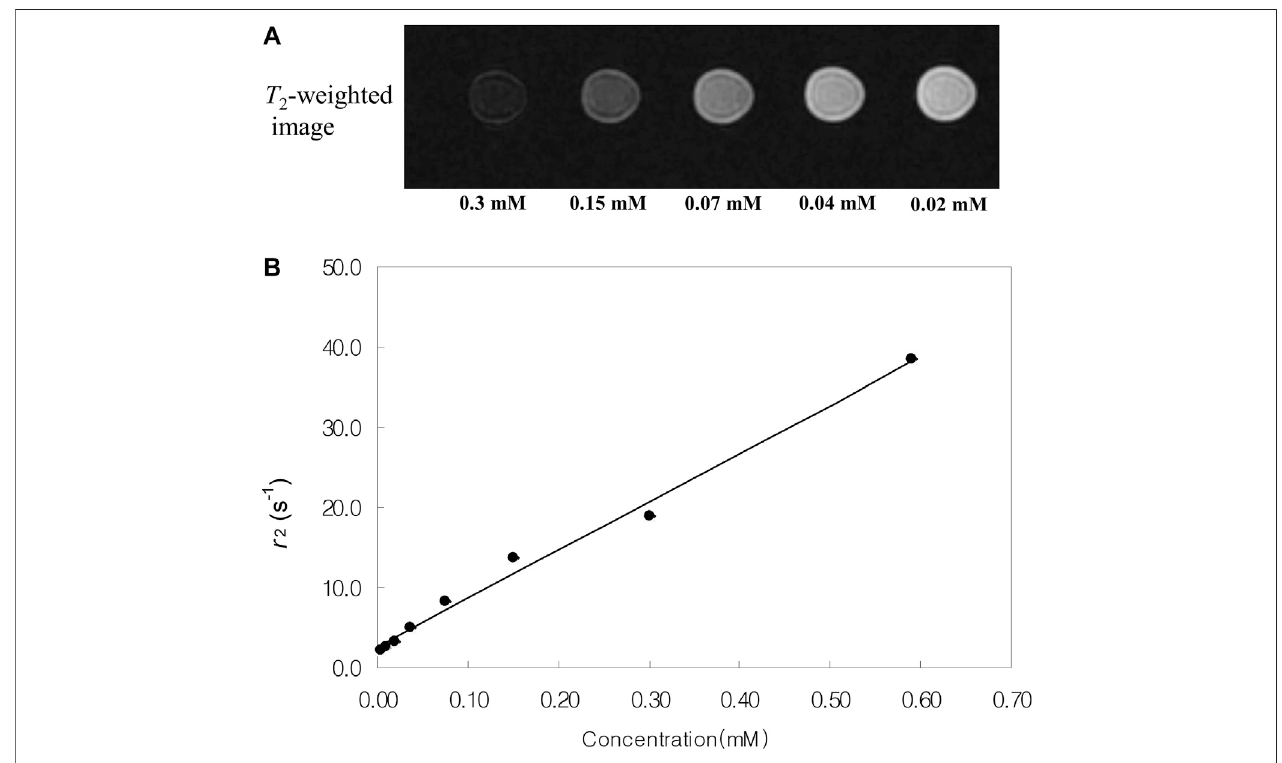
FIGURE 7 | (A) T 2 -weighted MR images and (B) spin-spin relaxivity ( r 2 ) of the iron nitride at silica core/shell nanoparticles with 11.6 nm core at various concentrations in water.